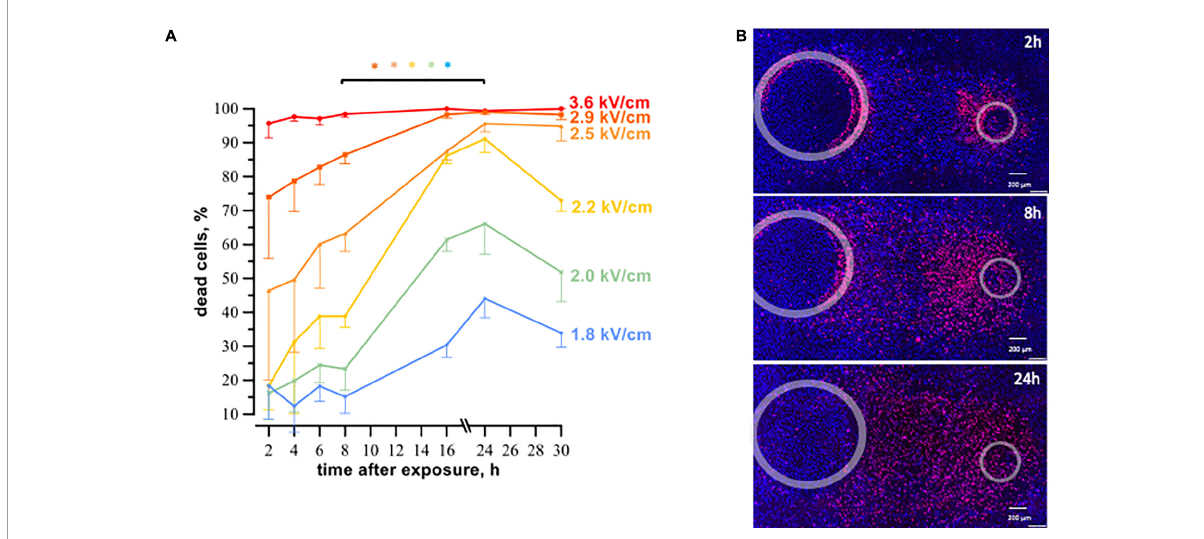
FIGURE4 The time course of cell death in human cardiomyocyte subjected to microsecond electric shocks (20 pulses at 1 Hz, 100 µ s, 300 V). (A) The plots display the percentage of dead cells in the regions with different electric field strength as a function of time after µ sPEF shocks exposure, mean ± SEM, 3–5 independent experiments for each time interval, * p < 0.05 for the difference in the percent of dead cells between different time intervals. Cells were labeled with propidium and Hoechst at time intervals ranging from 2 to 30 h after µ sPEF shocks see Figure 3 and text for more details. Panel (B) represents fluorescence images of human cardiomyocytes following µ sPEF shocks. Gray circles mark the footprints of the asymmetrical electrodes. Note the gradual increase of cell death over time with a maximum at 24